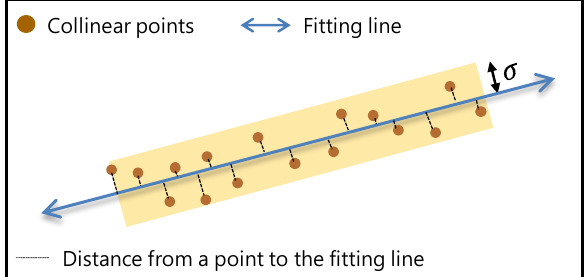
Figure 10. The conceptual illustration of the proposed line fitting process.